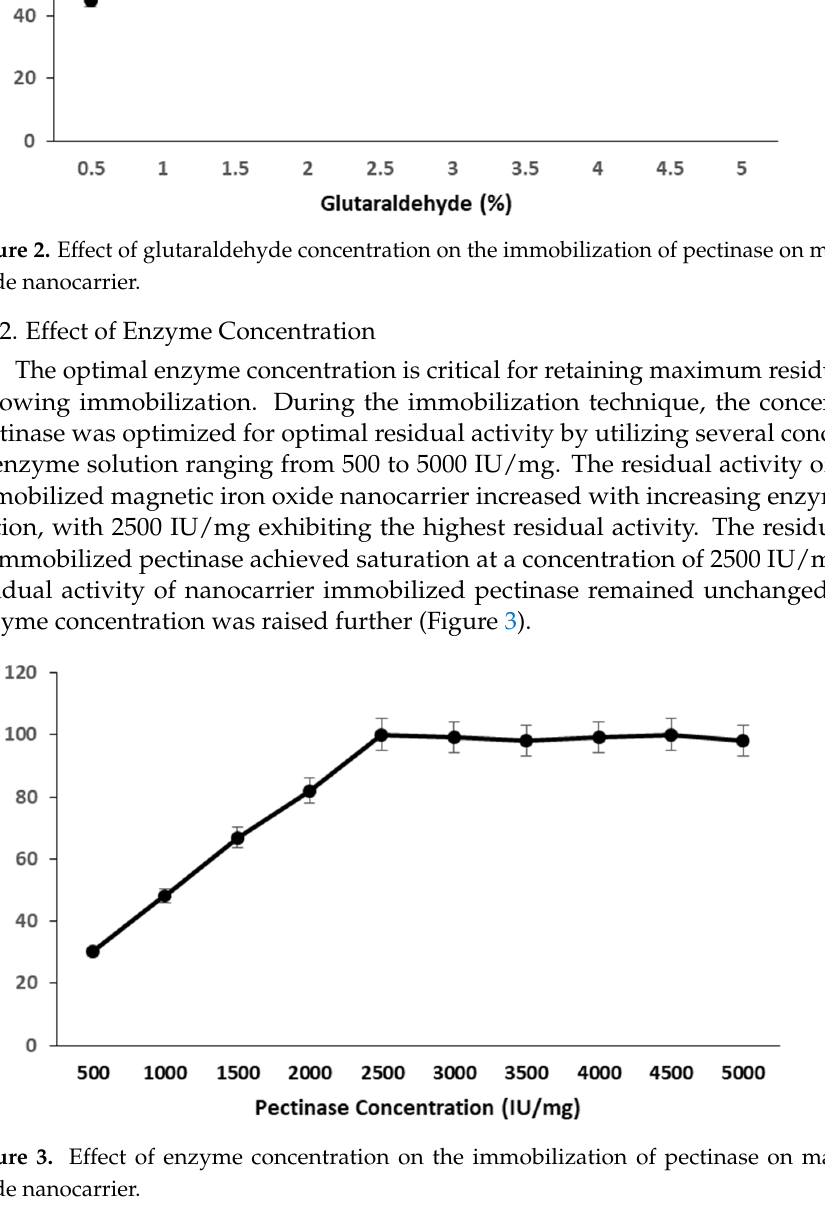
Figure 3. Effect of enzyme concentration on the immobilization of pectinase on magnetic iron oxide nanocarrier.